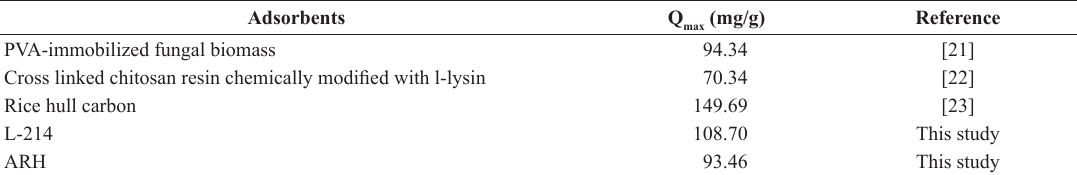
Table 3. Maximum adsorption capacities for the adsorption of gold ions, onto various adsorbents reported in the literature. Adsorbents